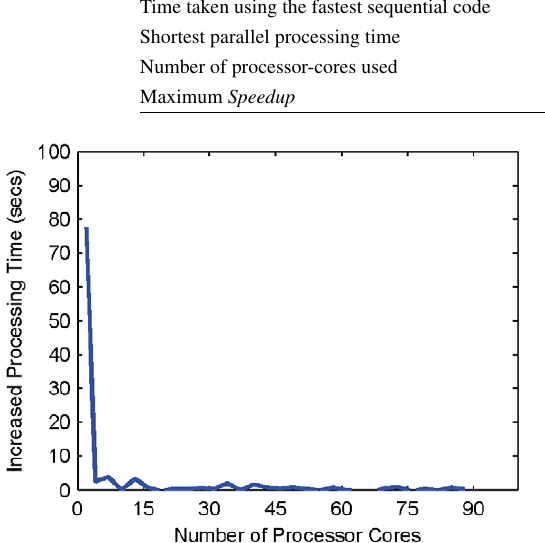
Fig. 8. Increased amount of processing time in Saving when using high compression quality. This figure shows the increased processing time using the compression quality of 100 over compression quality of 0 for TMA1, this plot shows the difference = (processing time for compression quality 100) − (processing time for compression quality 0). (Colours are visible in the online version of the article;